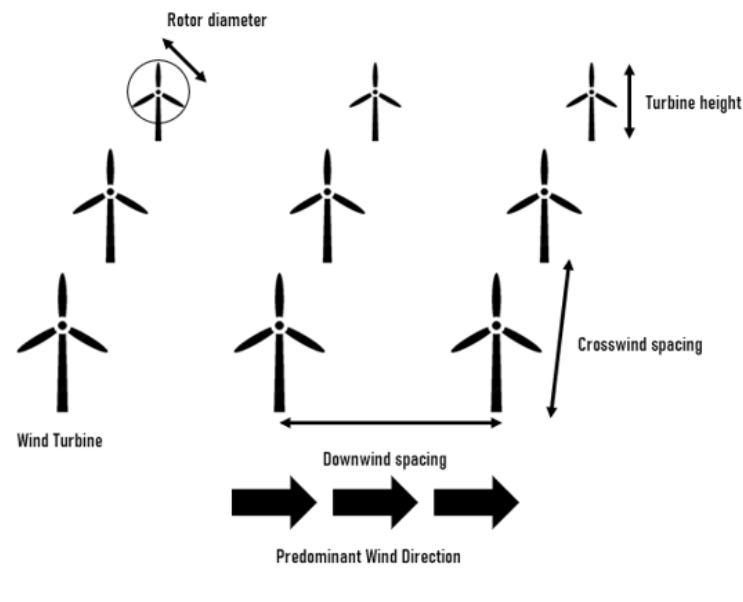
Figure 9. Micro-siting